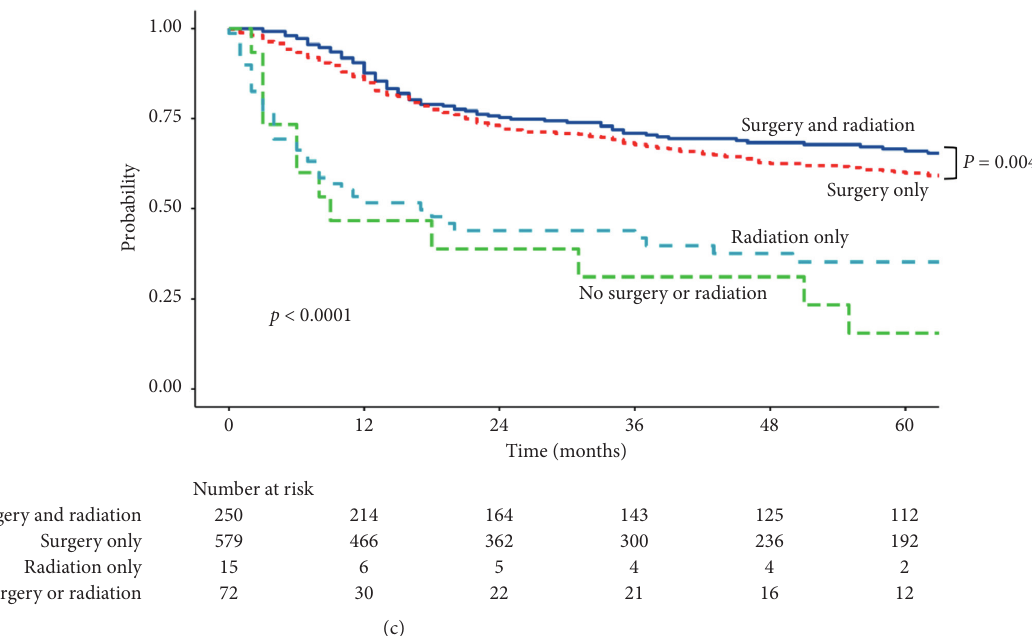
Figure 1: Kaplan–Meyer curve of overall survival. (a) Kaplan–Meyer curve of overall survival by surgical treatment. (b) Kaplan–Meyer curve of overall survival by T stages. (c) Kaplan–Meyer curve of overall survival by surgical and radiation